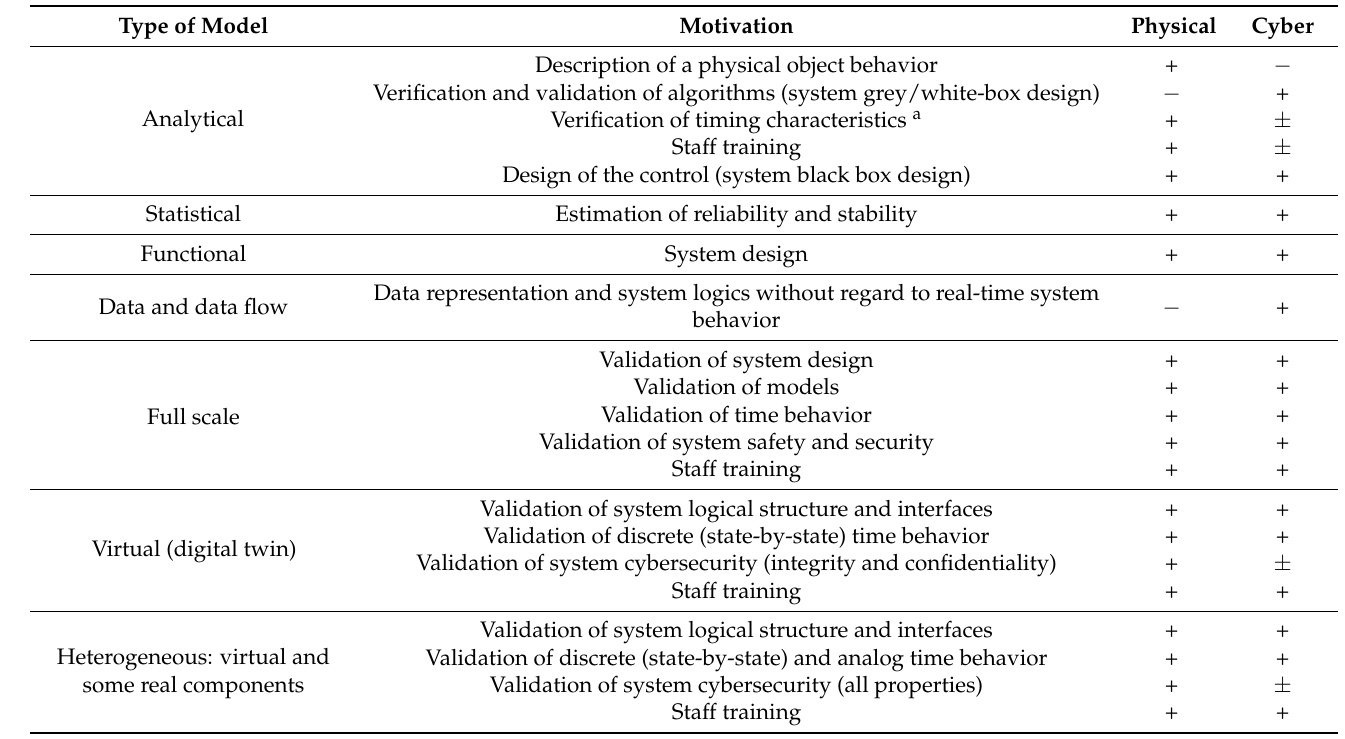
Table 1. Comparison of the properties of the